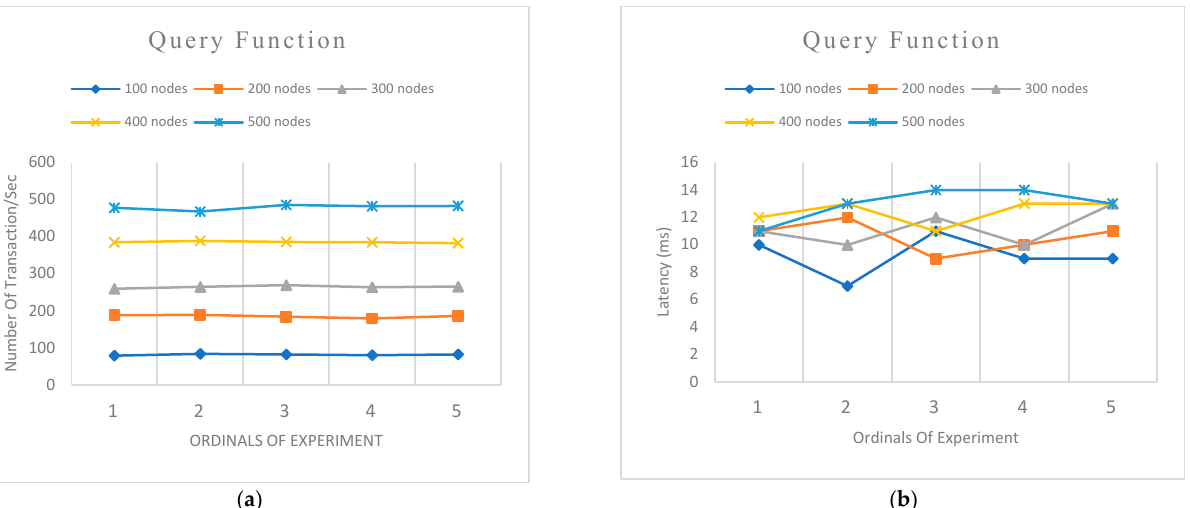
Figure 8. System ( a ) Transactions per second (TPS) of query function with varying node groups ( b ) Latency of query function with varying node groups.